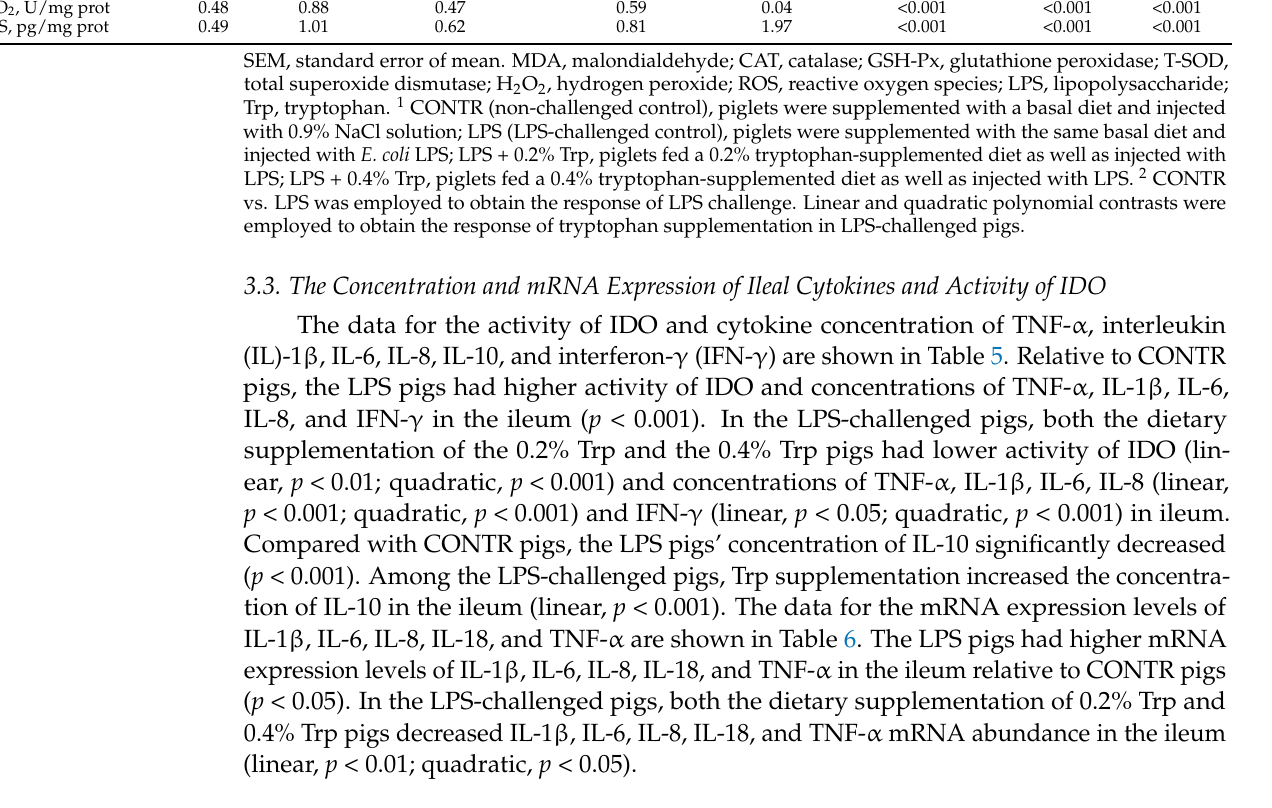
Table 5. Effects of tryptophan on the ileal cytokine concentration and activity of IDO after 4 h LPS challenge in